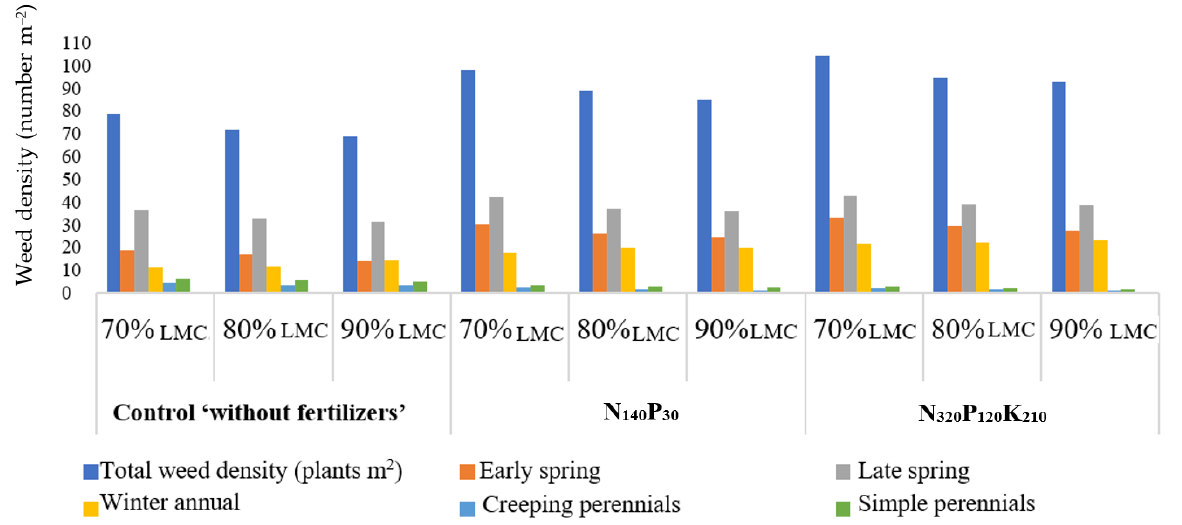
Figure 3. Weed dynamic affected by different treatments 20 days after planting.